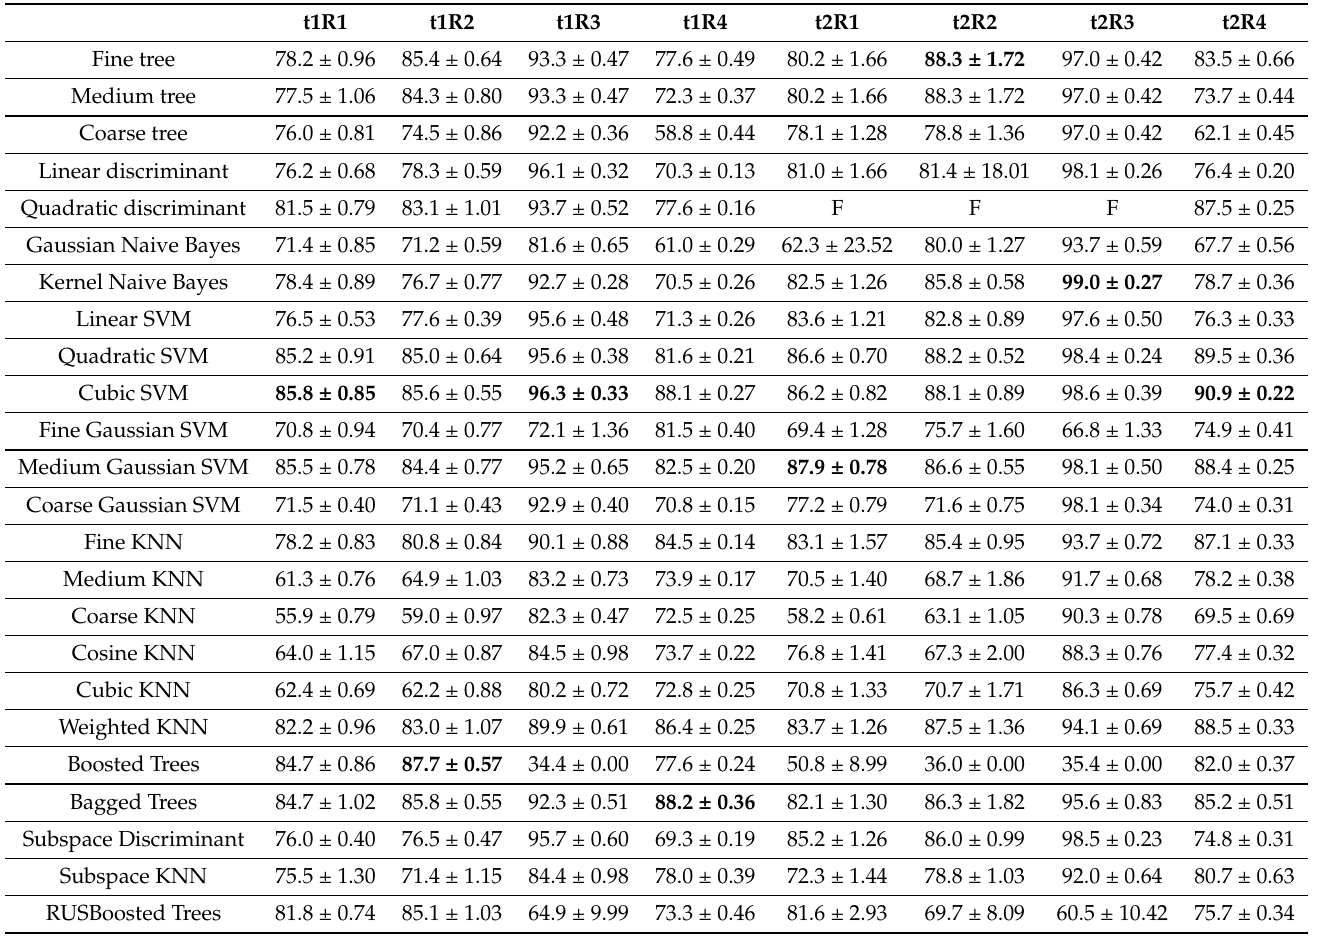
Table 4. Resulting success rate of classification of individual methods for experiments with combined predictors. The best results are marked in bold. Note: F-model failed (one or more of the classes have singular covariance matrices).